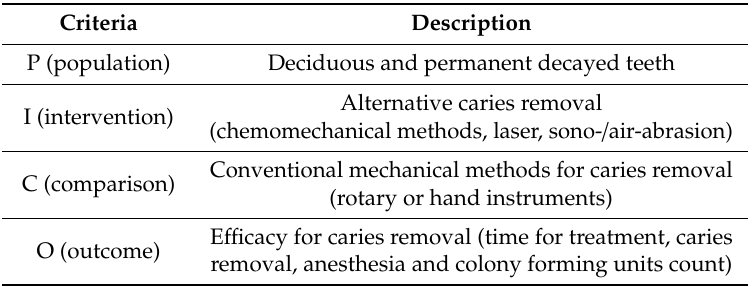
Table 1. Population, Intervention, Comparison, and Outcome (PICO) question.